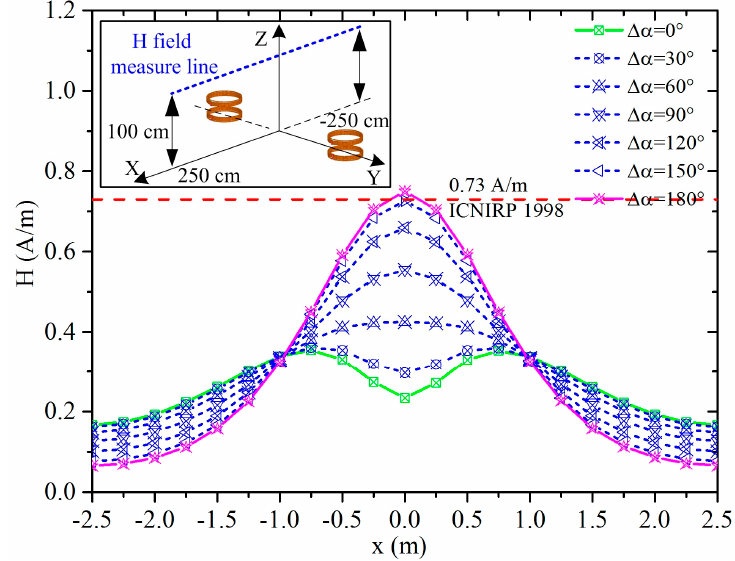
Figure 4. Magnetic field intensity (A/m) of two parallel WPT systems with phase difference along the measure line. ICNIRP: International Committee on Non-Ionizing Radiation Protection.